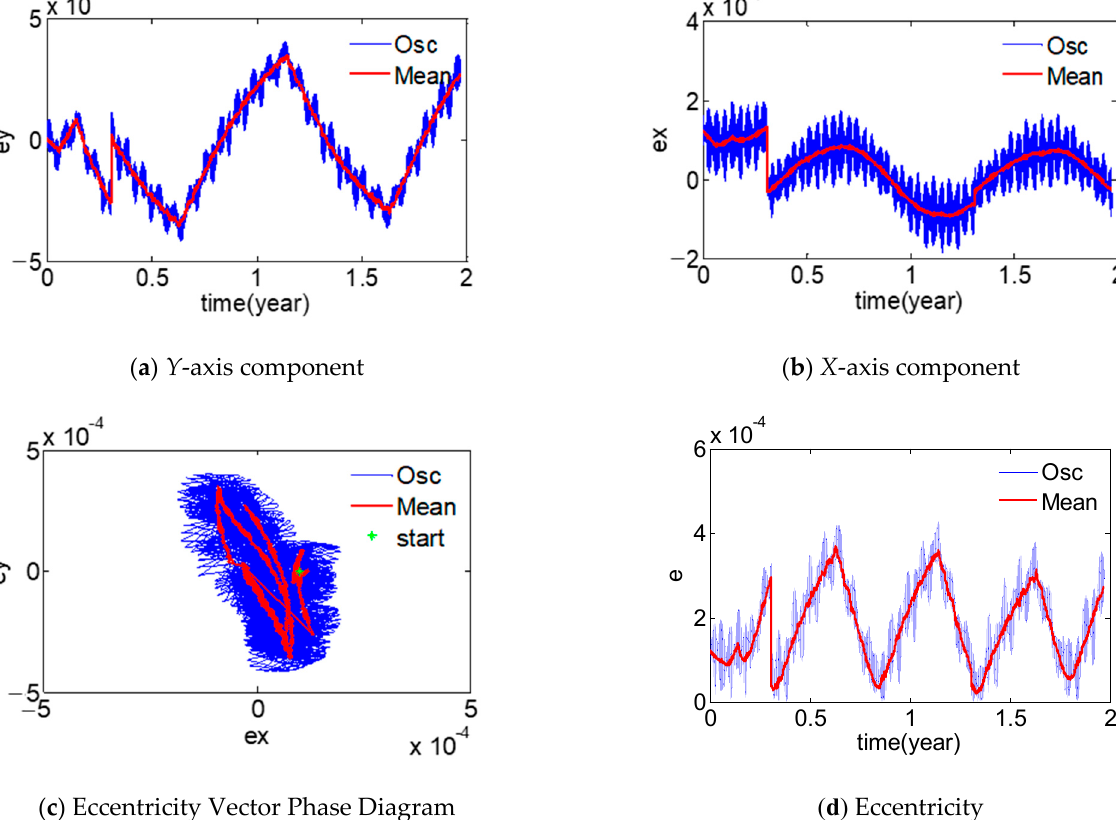
Figure 5. Result of eccentricity vector adjustment .